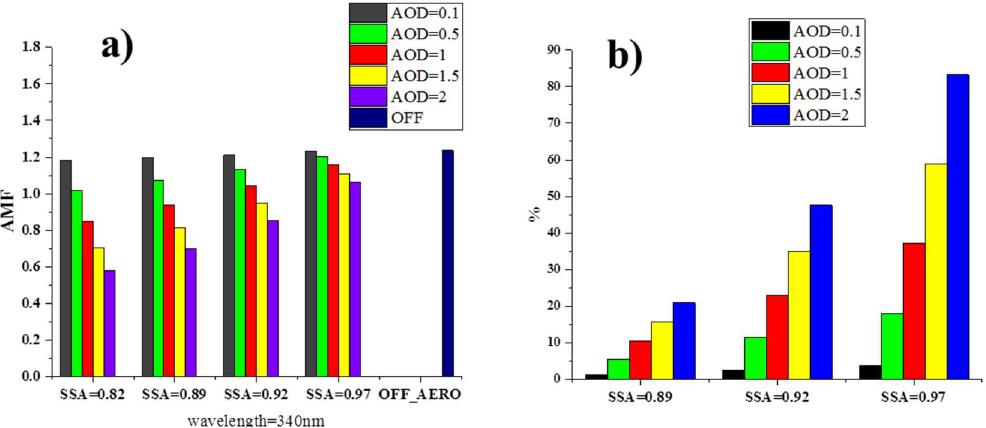
Figure 10. AMF values corresponding to single scattering albedo (SSA) and aerosol optical depth (AOD): ( a ) absolute AMF; ( b ) relative change.